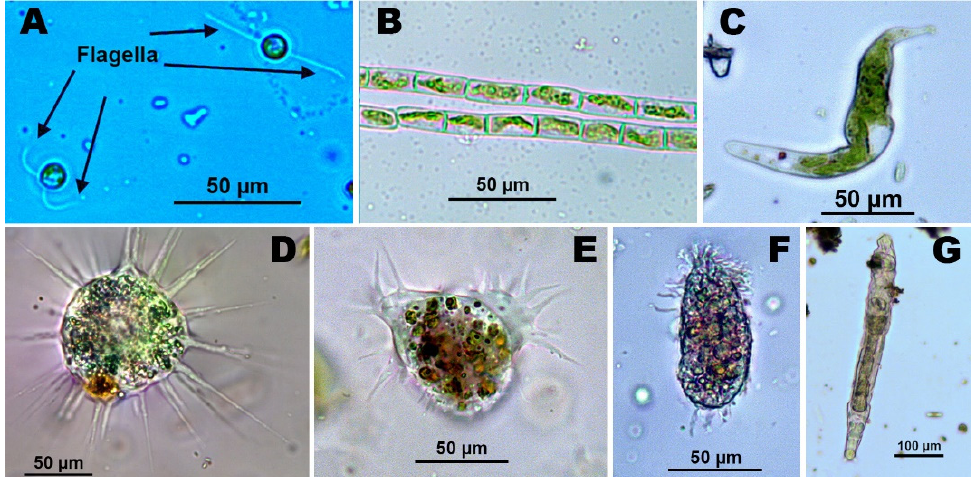
Figure 2. ( A ) Unicellular algae ( Chlamydomonas acidophila ), ( B ) Filamentous algae ( Klebsormidium sp.), ( C ) Euglena mutabilis , ( D ) Protozoo Heliozoa, ( E ) Protozoo Ciliata, ( F ) Amoeba, ( G ) Rotífer.